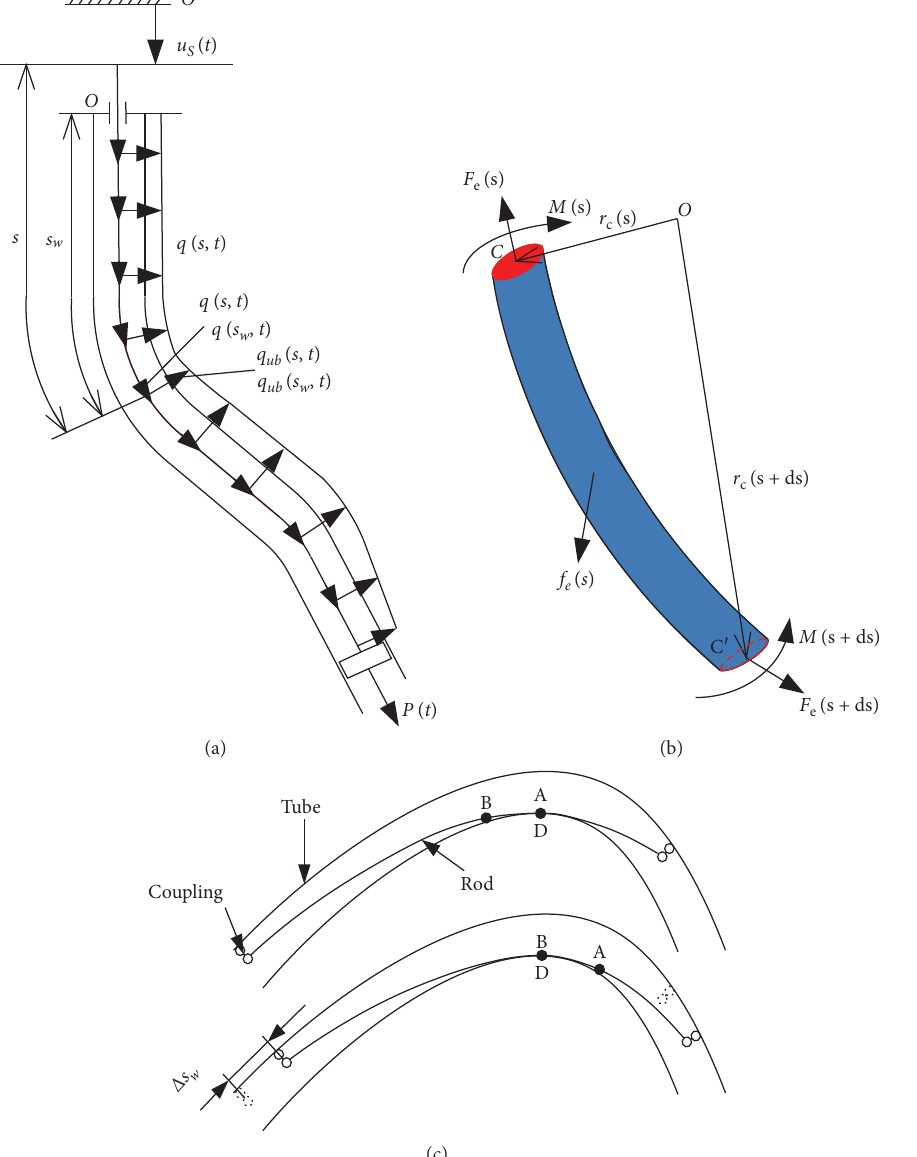
Figure 2: Mechanical model of transverse vibration of SRS. (a) Mechanical model. (b) Element model force. (c) Schematic diagram of borehole trajectory